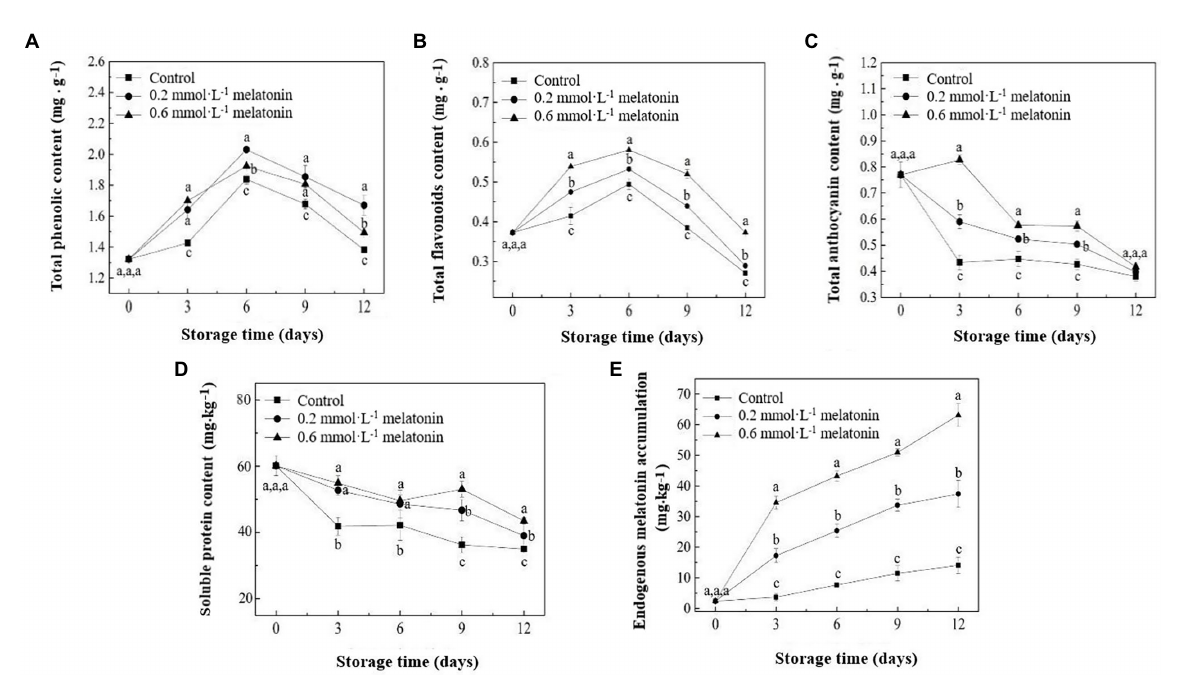
FIGURE 4 (A) Total phenolic content, (B) total flavonoids content, (C) total anthocyanin content, (D) soluble protein content, and (E) endogenous melatonin accumulation of the litchi samples during cold storage. Data represent mean values and standard errors of three replicates. Different lowercase letters (a–c) indicate significant differences between different groups ( p <